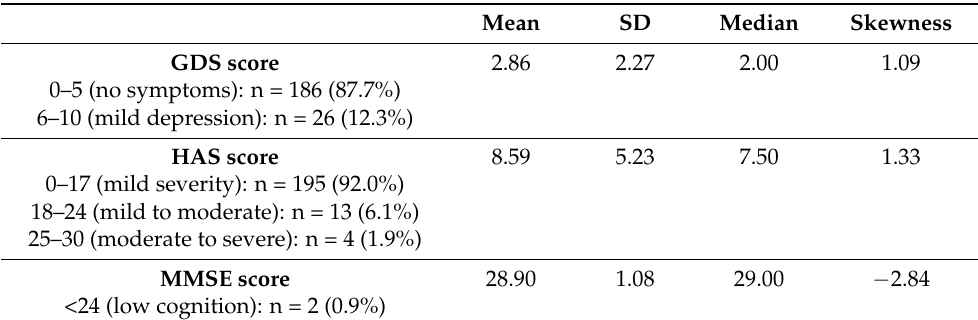
Table 6. Scoring levels of GDS, HAS, and MMSE of the total sample.